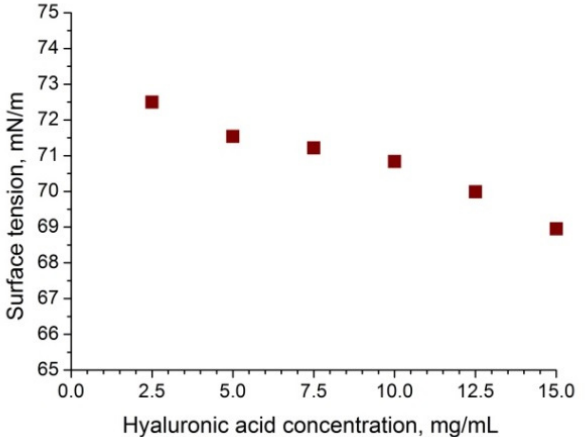
Figure 5. Dependence of the surface tension from hyaluronic acid concentration at 25.0 ± 1.0 °C.